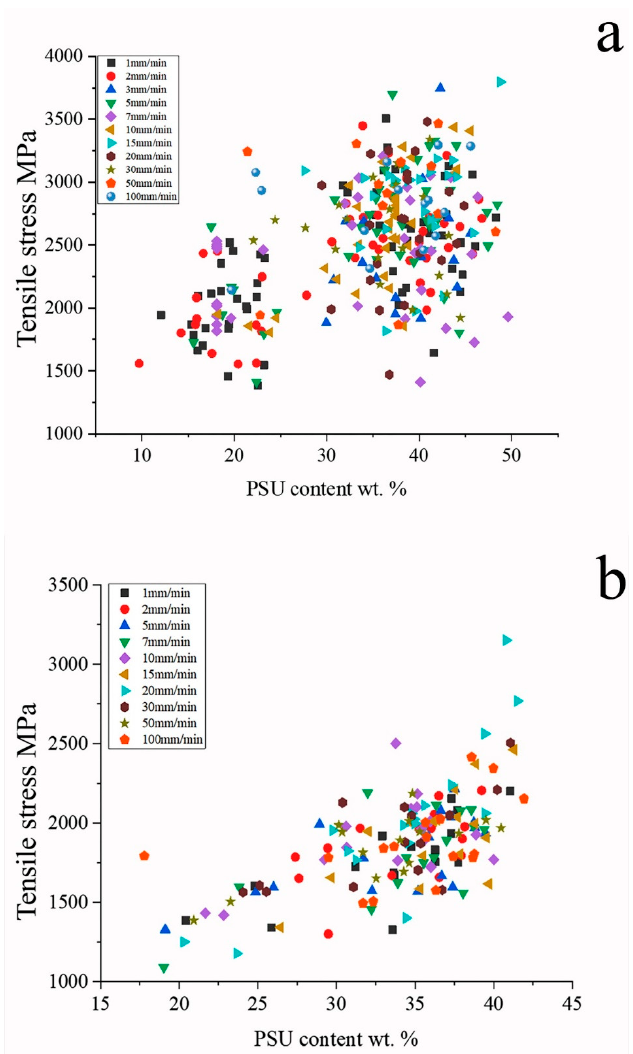
Figure 6. Dependences of tensile strength on the polysulfone content for Toray T700 ( a ) and UMT400 ( b ) based composites at various loading rates (indicated in figure).